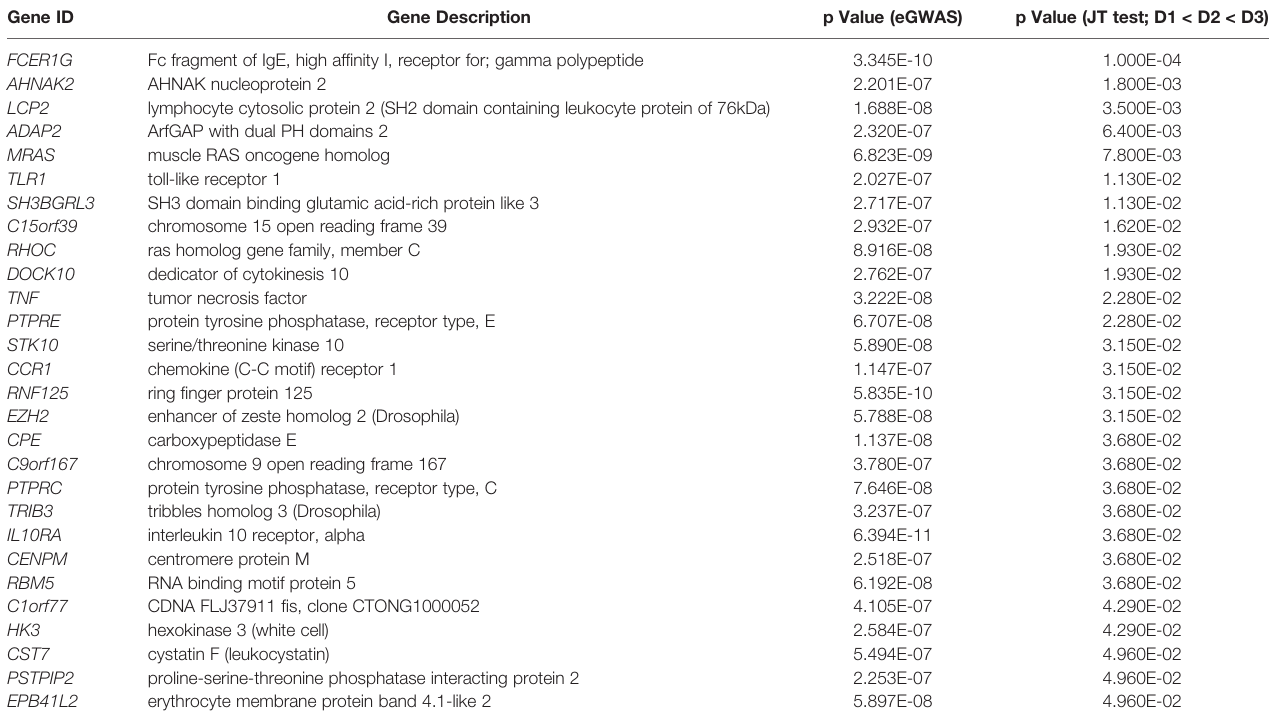
TABLE 2 | List of genes with signi fi cantly increase expression in PBMCs and glomeruli. Gene ID Gene